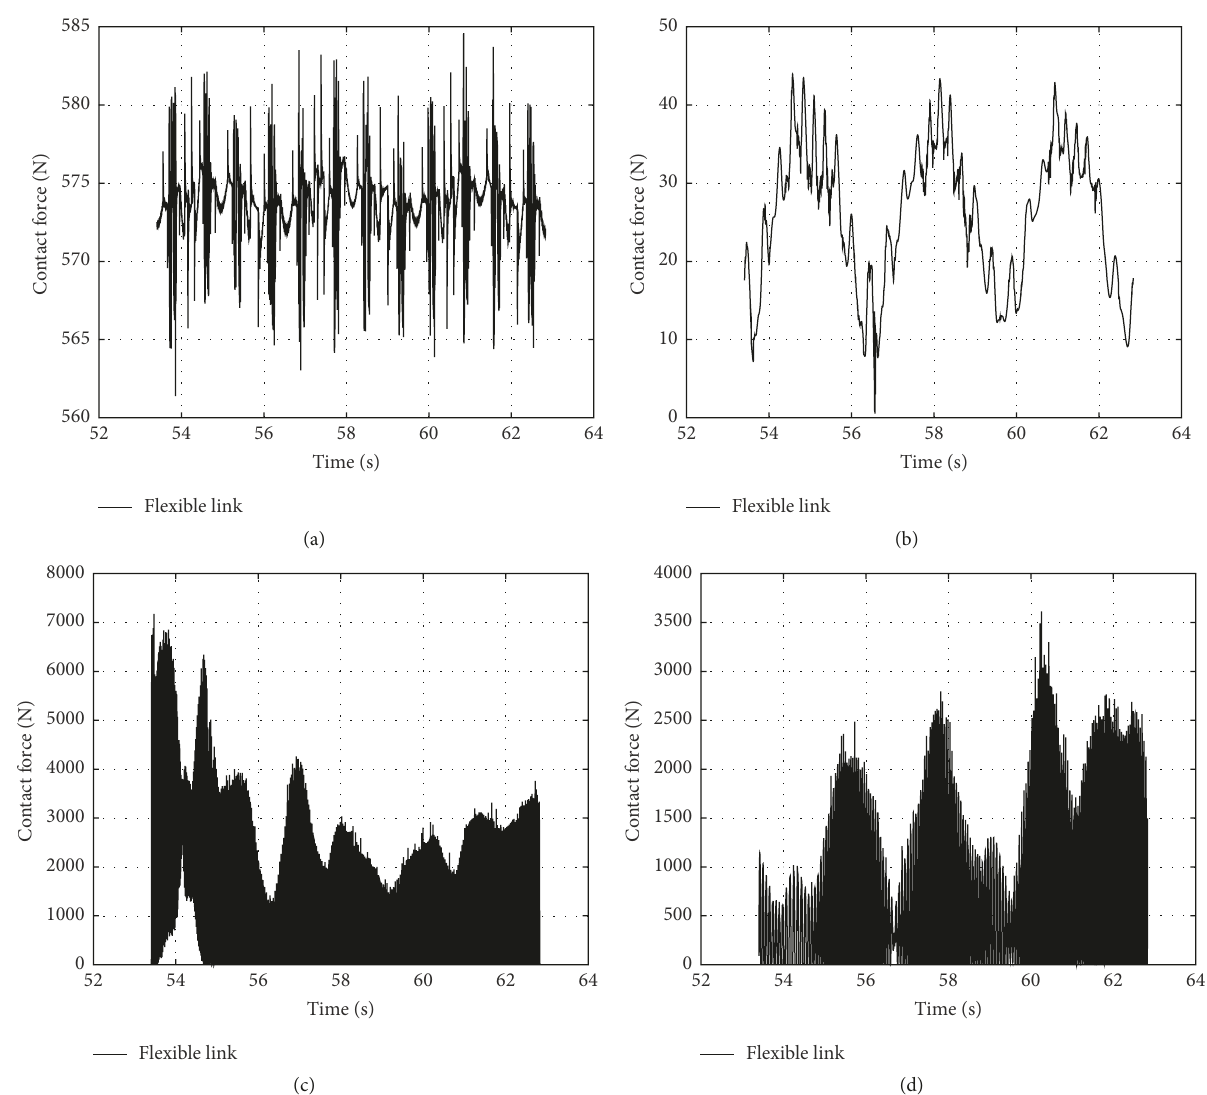
Figure 20: Contact force of different clearances: (a) 𝑐 = 0.01 mm; (b) 𝑐 = 0.1 mm; (c) 𝑐 = 0.25 mm; (d) 𝑐 = 0.5